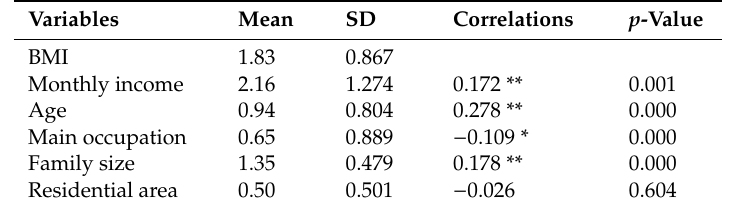
Table 9. Correlation analysis between socioeconomic and environmental factors and BMI.